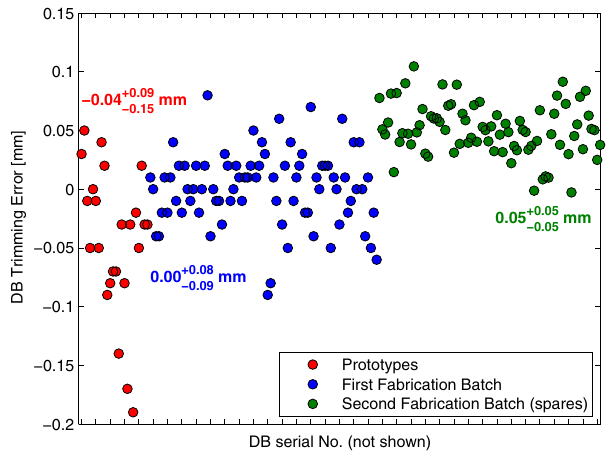
FIG. 4. Errors in the implementation of the trimming instruc- tions (i.e. difference between the post-trimming mechanical survey with respect to the trimming instructions based on rf measurements) in the three production batches. The labels appearing below the data points show the average values and uncertainties of each dataset (minimum and maximum deviations).